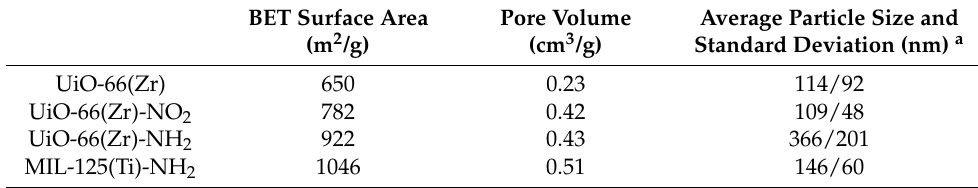
Figure 3. XPS survey spectrum ( a ) and high-resolution C 1s ( b ), O 1s ( c ), N 1s ( d ), Zr 3d ( e ) and Ti 2p ( f ) spectra of the MOFs under study. Legend: UiO-66(Zr) (gray), UiO-66(Zr)-NO 2 (orange), UiO-66(Zr)-NH 2 (green) and MIL-125(Ti)-NH 2 (wine red). Table 1. BET surface area, pore volume and average particle size and standard deviation of the MOFs under